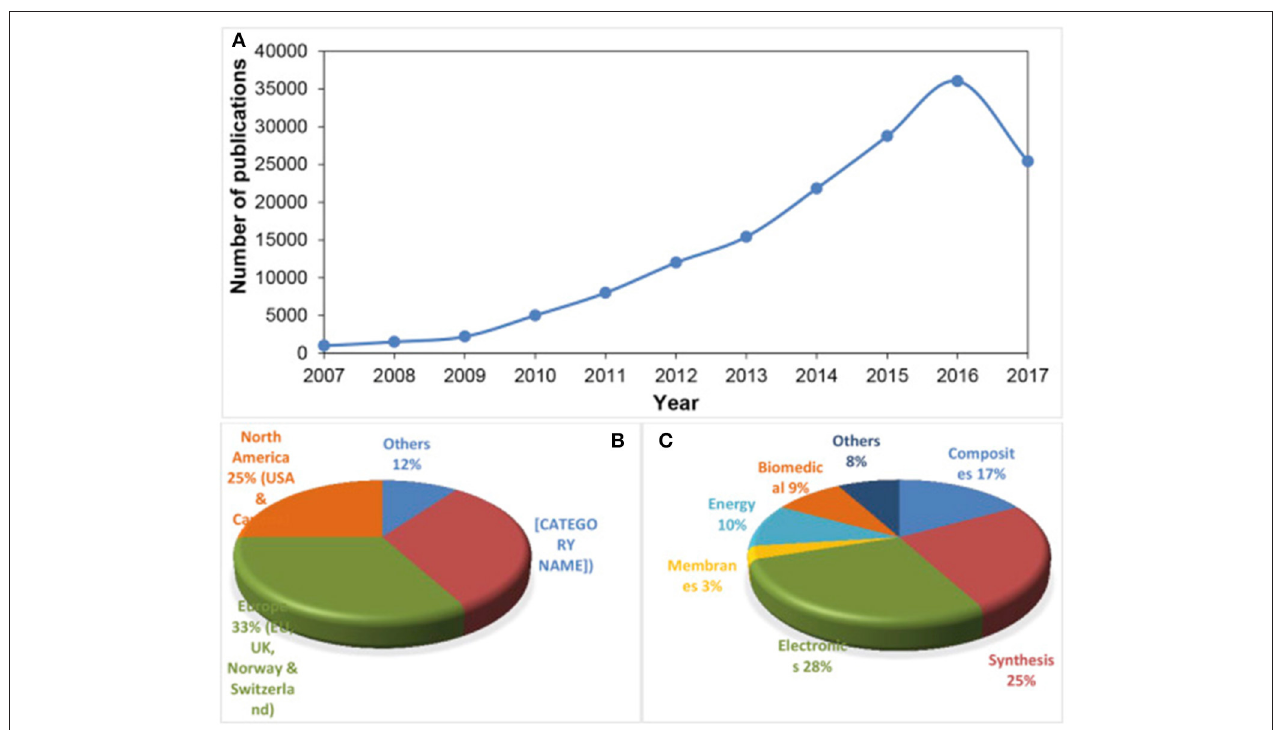
FIGURE 2 | (A) Publications on graphene from 2007 to August 2017, and expected to reach at least 40,000–45,000 publication by the end of 2017 [Source: Web of Science], (B) proportion of total publications per country and (C) per sector.